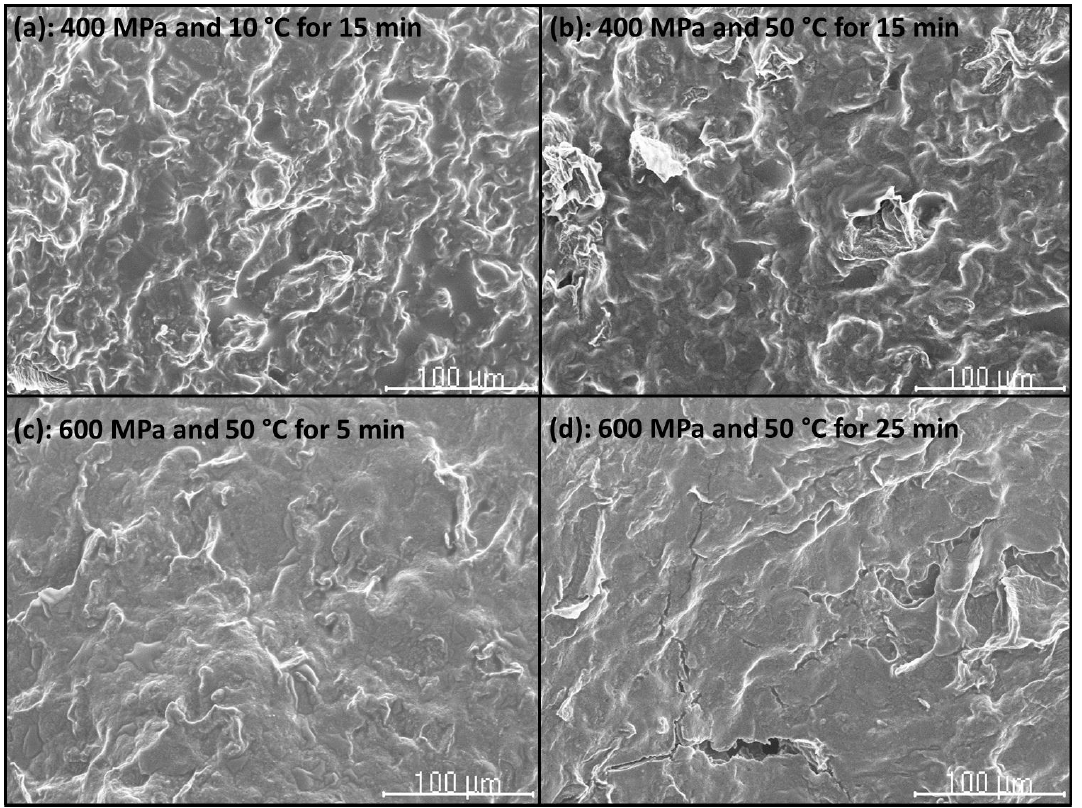
Figure 8. Scanning electron micrographs of pressurized heat-induced CF gels at (300×) magnification: ( a ) Heat-induced CF gel after pressurization at 400 MPa and 10 °C for 15 min, ( b ) Heat-induced CF gel after pressurization at 400 MPa and 50 °C for 15 min, ( c ) Heat-induced CF gel after pressurization at 600 MPa and 50 °C for 5 min, ( d ) Heat- induced CF gel after pressurization at 600 MPa and 50 °C for 5